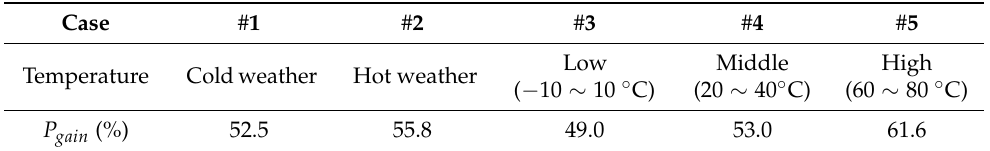
Table 2. Average P gain results for the case studies. Case #